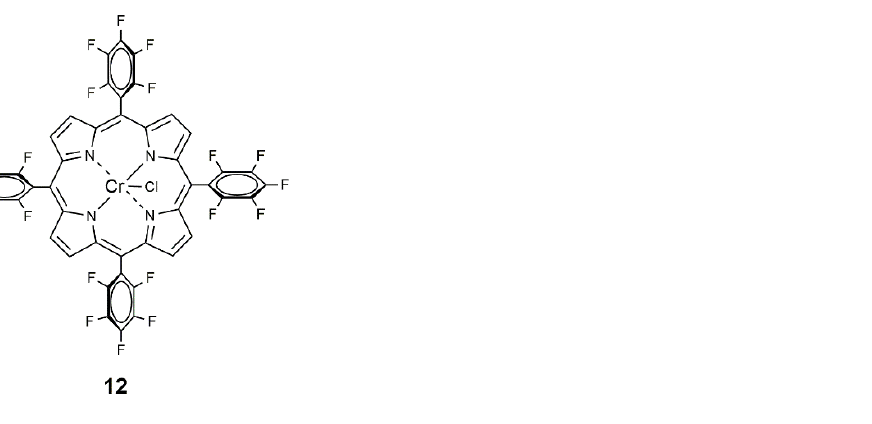
the reaction medium.